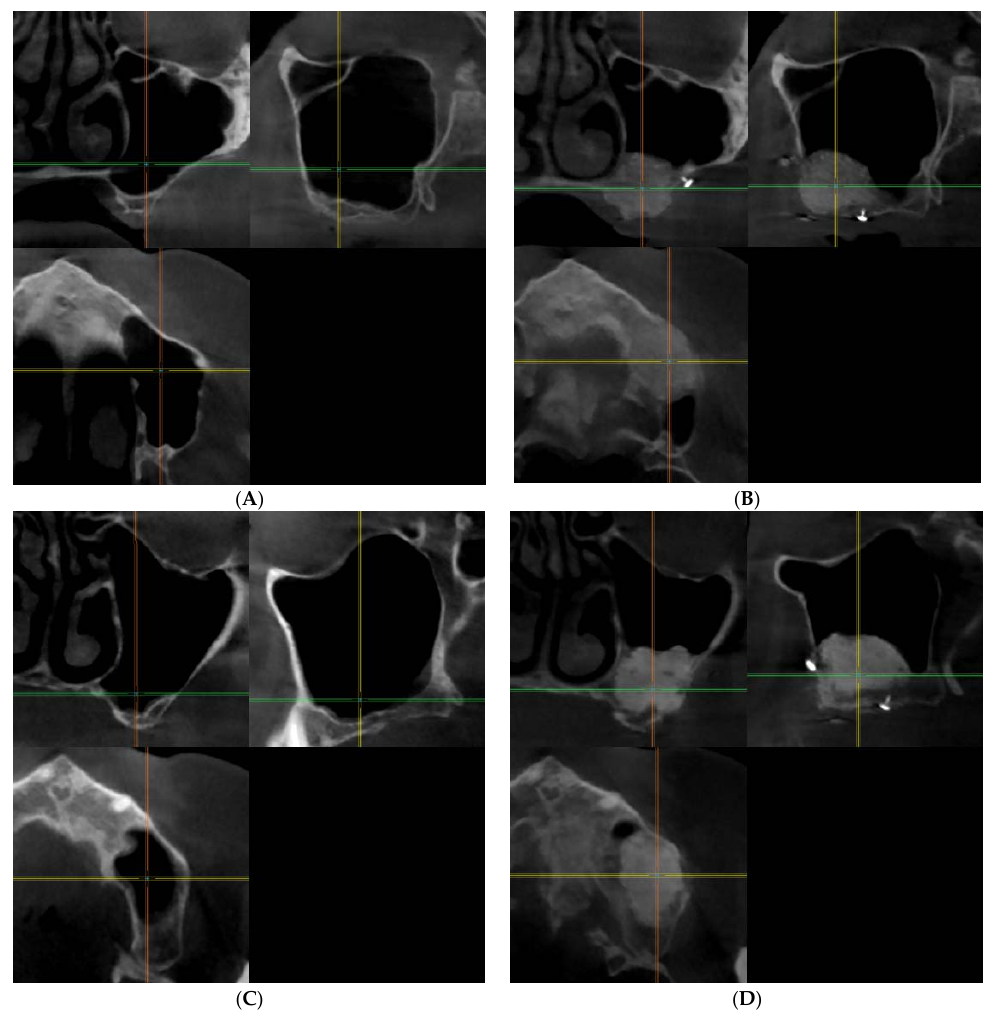
Figure 1. Presents pre- and postoperative cone beam computed tomography (cbCT) images of the augmented sinuses in both study groups. ( A ) preoperative and ( B ) postoperative images of one of the patients of the BoneAlbumin group, ( C ) preoperative and ( D ) postoperative images of one of the patients in the ABBM group. On each image the coronal view is presented on the upper left, the sagittal view is presented on the upper right and the axial view is presented on the lower left window. Bone core biopsy material was fixed in 10% buffered formaldehyde solution. Following decalcination and dehydration, the biopsy material was embedded in paraffin and 20 μ m sections